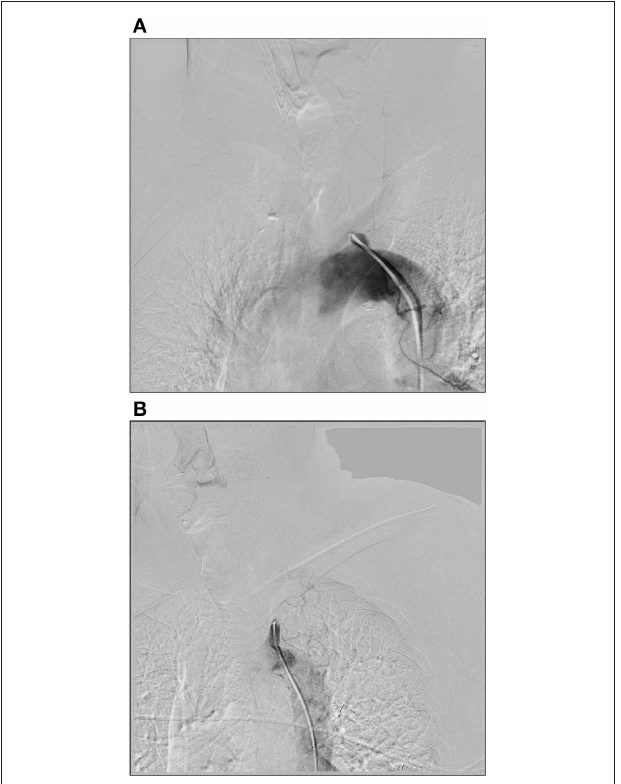
FIGURE 1 | Two types of stumps. (A) The obtuse lesion means the stump were short and flat. (B) The beaklike lesion had a tip on the top of the stump.